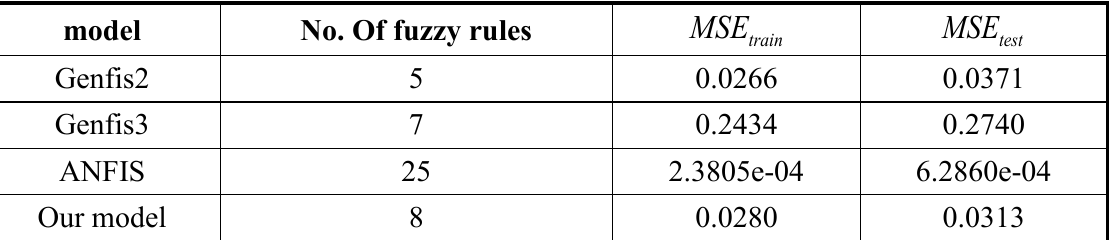
Table 1. The comparison of the different